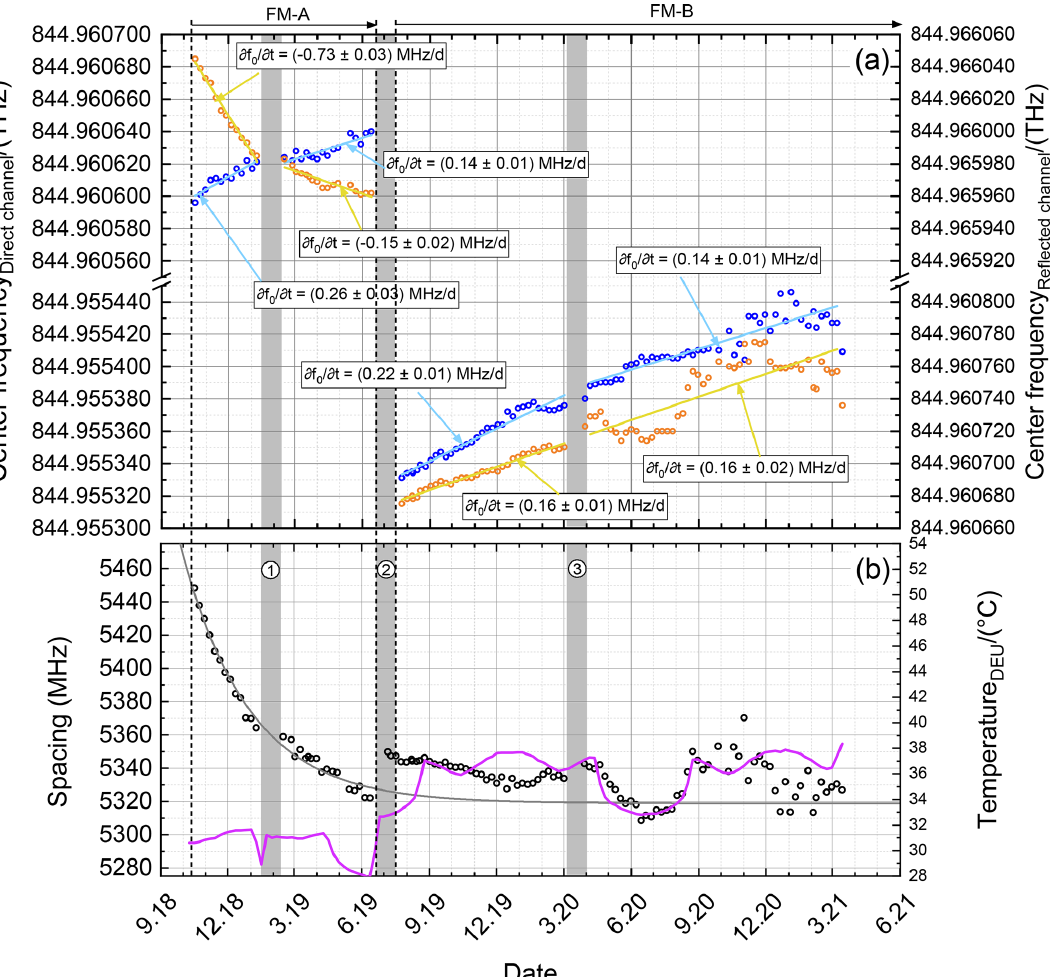
Figure 8. (a) Center frequencies for the direct channel (blue) and the reflected channel (orange) derived by fitting Eqs. (9) and (11) to the ISR data sets obtained from October 2018 to March 2021 (see also Table 2). Corresponding line fits to distinct time periods (period 1: 17 October 2018 to 9 January 2019; period 2: 15 February to 13 June 2019; period 3: 25 July 2019 to 2 March 2020; period 4: 30 March 2020 to 15 March 2021) are shown in light blue and yellow, respectively, and the derived slopes ( (cid:49)f 0 /(cid:49)t ) are given by the insets. (b) Corresponding spectral spacing (cid:49)f 0 between the direct channel and the reflected channel of the FPIs (black circles) and an exponential decay fit (gray) to show the settlement of the spacing drift. Special time periods are indicated by gray bars (1: instrument shut off due to a GPS reboot anomaly; 2: switch from FM-A to FM-B; 3: laser CPT